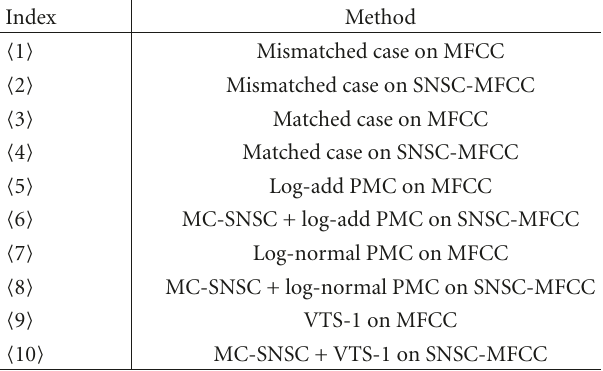
Table 1: Index table for the ten compensation